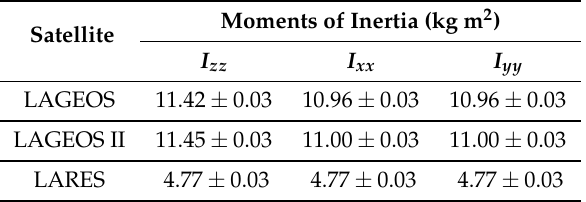
Table 1. Principal moments of inertia of LAGEOS, LAGEOS II and LARES in their flight